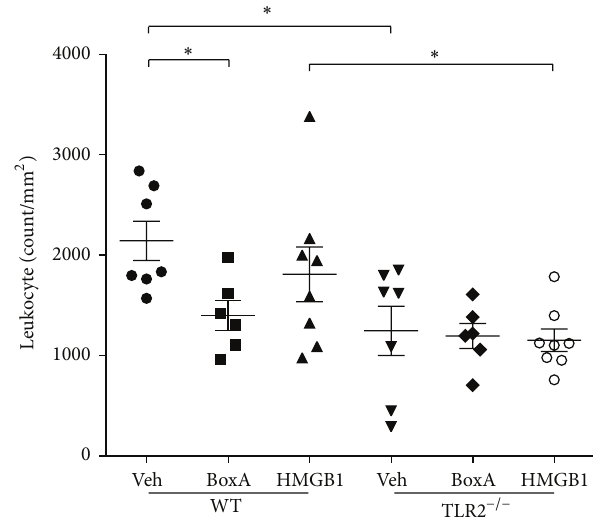
Figure 2: Leukocyte infiltration after myocardial ischemia (30min) and reperfusion (24hrs). Box A reduced leukocyte infiltration in WT animals, while it had no effect in TLR2 −/− animals. HMGB1 injection did not affect leukocyte infiltration in both WT and TLR2 −/− . ∗ 𝑃 < 0.05